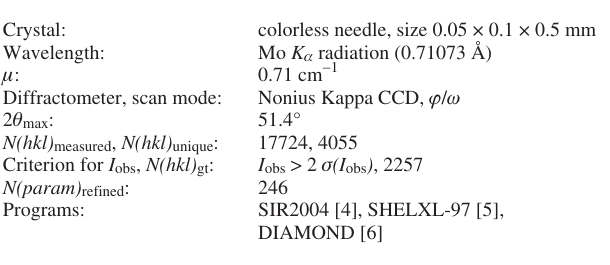
Table 1. Data collection and